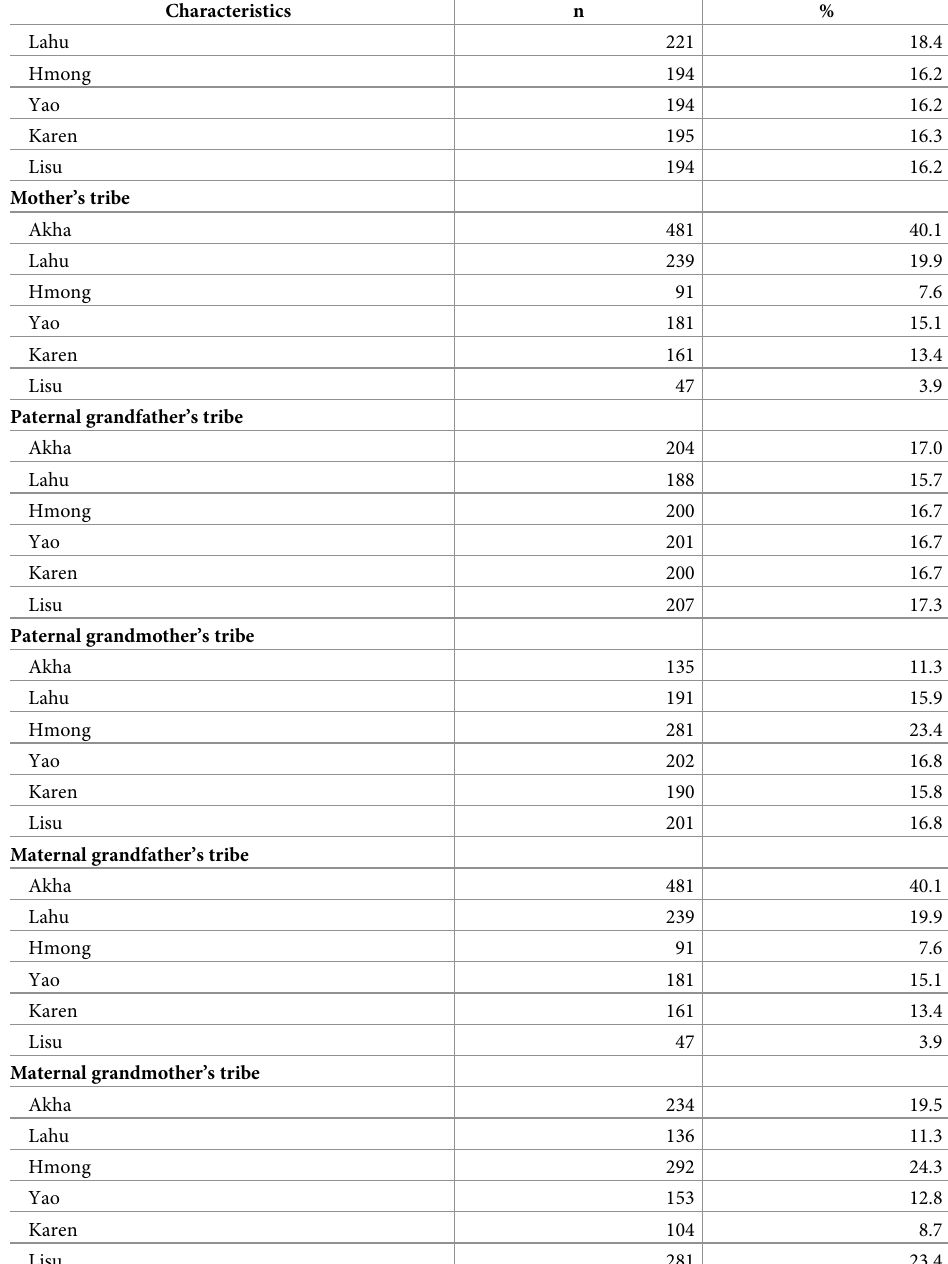
According to medical history, only 1.8% reported having a medical condition, 1.1% had anemia, and a large proportion had taken ferrous sulfate (98.7%) (Table 2). Comparisons of the mean corpuscular volume (MCV), mean corpuscular hemoglobin, hemoglobin (Hb), hematocrit (Hct), and red blood cells between those who were positive in either or both of the OF and DCIP tests and those who had negative results in both tests revealed significant differences (p-value = 0.010) (Table